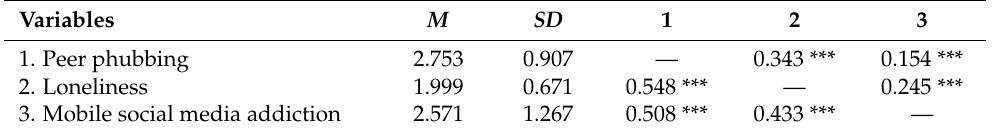
Table 2. Intercorrelations between variables.